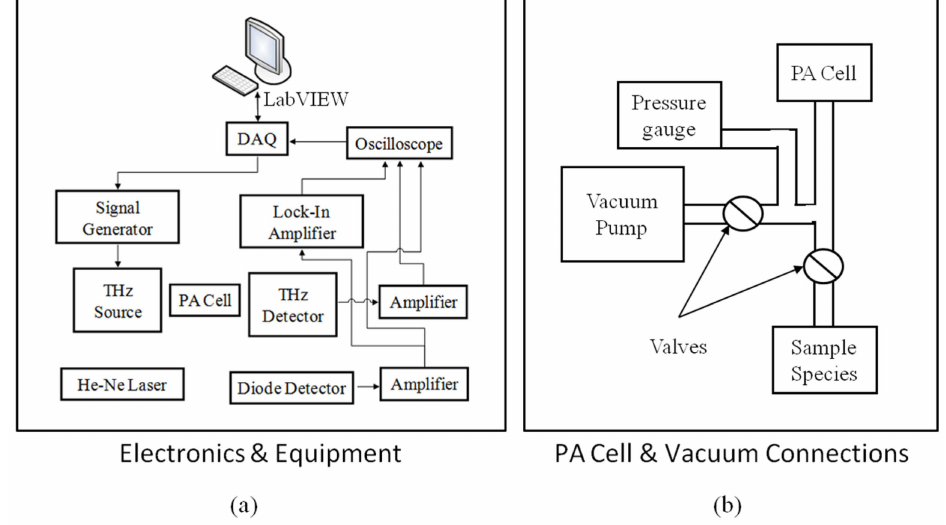
Figure 10. Block diagram showing ( a ) the electronics test equipment configuration and ( b ) the photoacoustic (PA) cell and test chamber vacuum